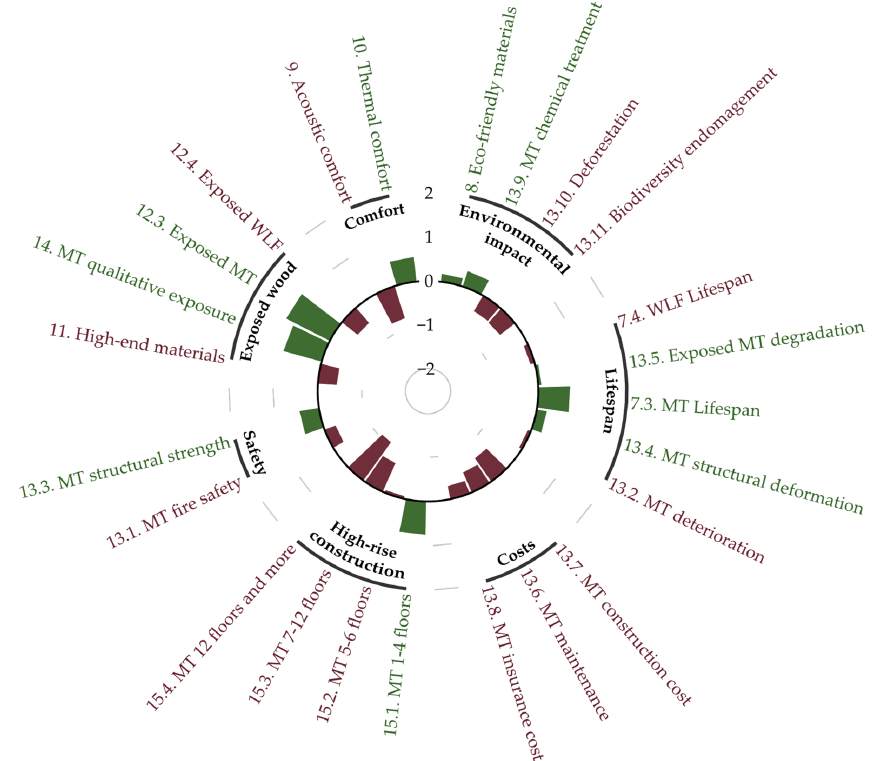
Figure 7. Average response profile of the sample about mass timber and wood light-frame. Items in green show a positive perception, items in red a negative perception.